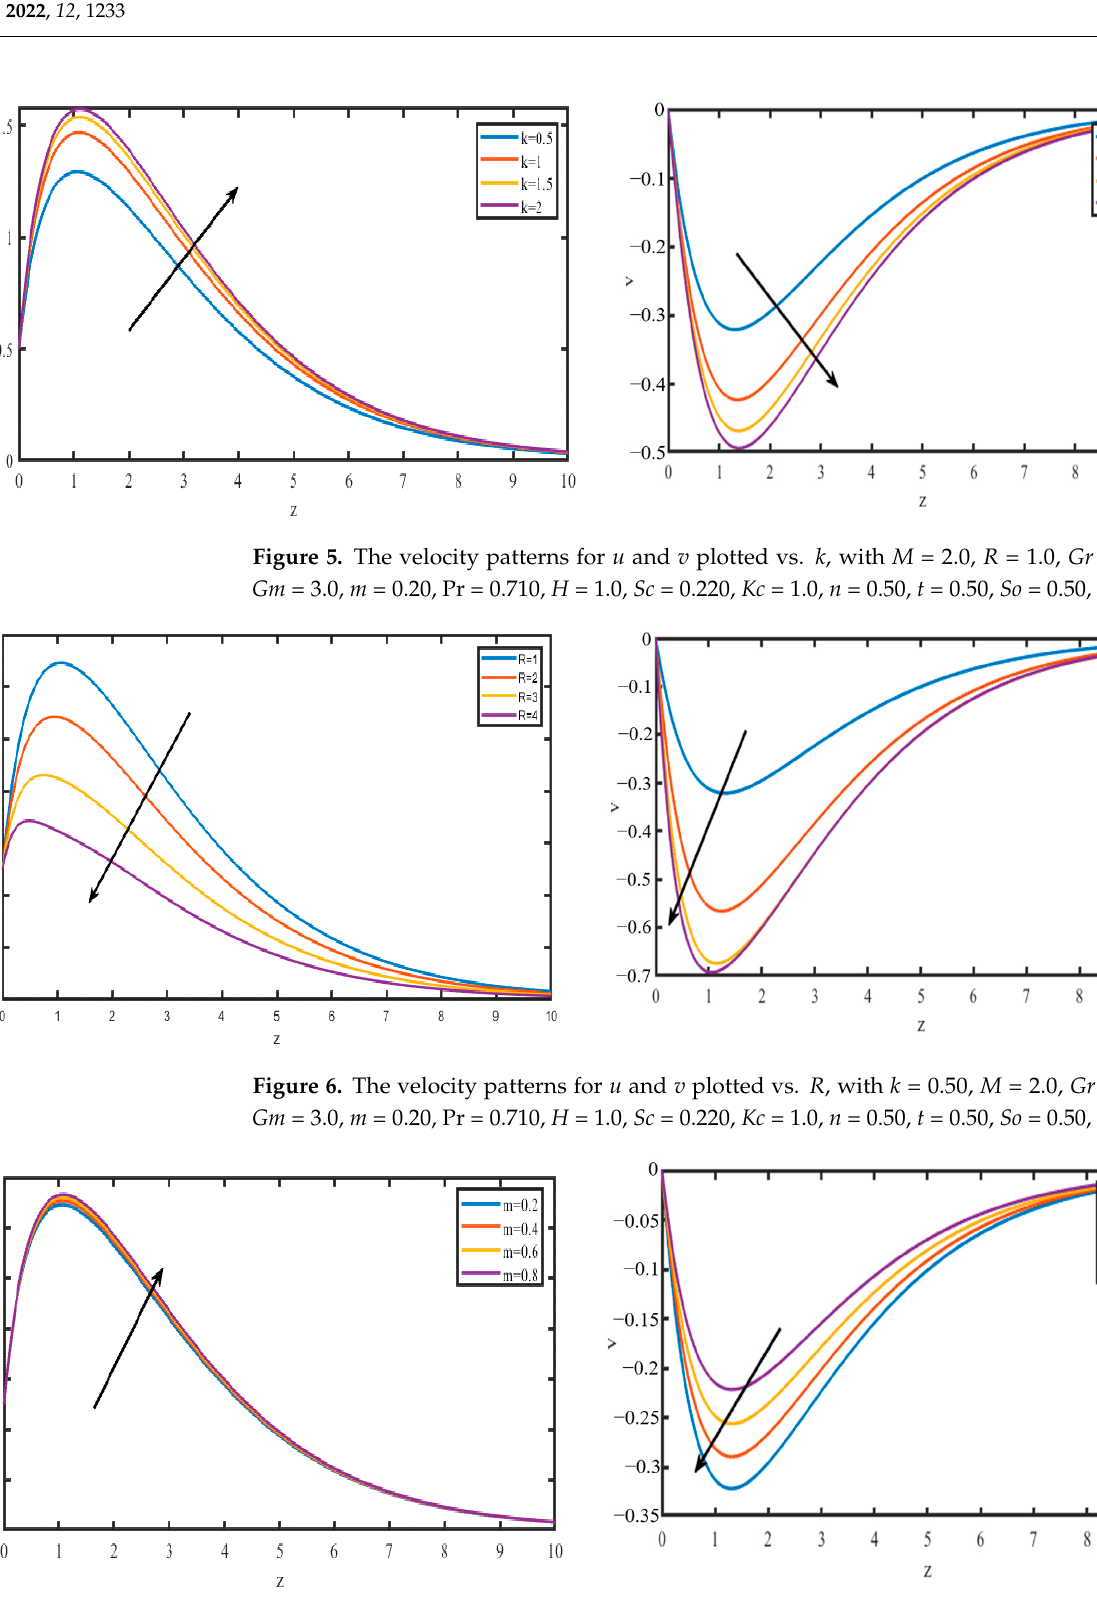
Figure 7. The velocity patterns for u and v plotted vs. m, with k = 0.50, R = 1.0, Gr = 5.0, S = 1.0, Gm = 3.0, M = 2.0, Pr = 0.710, H = 1.0, Sc = 0.220, Kc = 1.0, n = 0.50, t = 0.50, So = 0.50, F = 1.0.